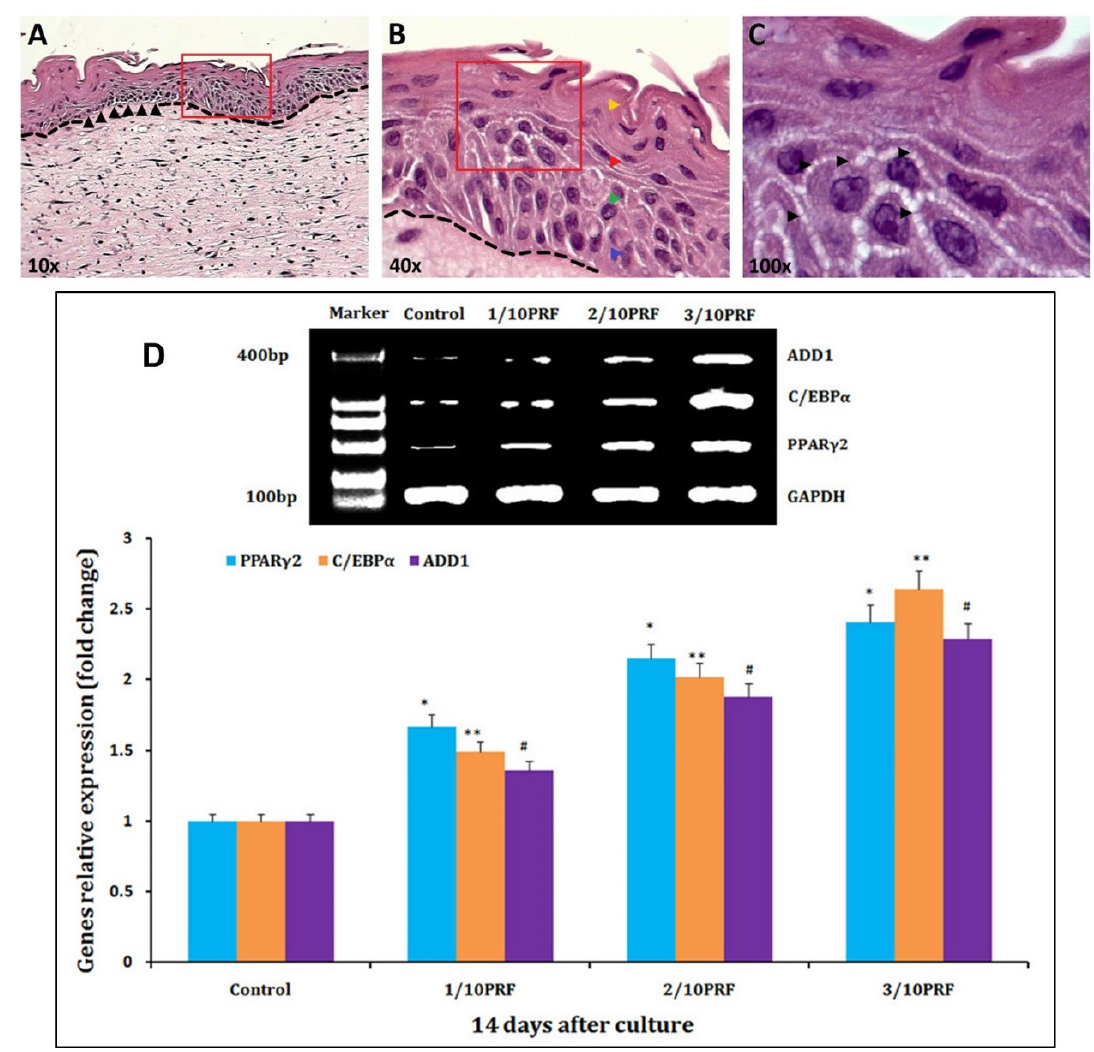
Figure 10. Histological features of skin organotypic cultures (ORGs) determined by H&E, after 21 days. ( A ) Whole structure of the ORGs (10×). A clear dermal–epidermal separation (dashed line) and a possible basal membrane (black head arrows) can be seen. ( B ) The enhanced area (40×) indicated by the red inset in ( A ). Four differentiation stages of the epidermis: the basal layer (blue head arrow), the spinous layer (green head arrow), the granular layer (red head arrow), and the horny layer (yellow head arrow), and the morphological associated changes in keratinocytes through the different layers of the epidermis. ( C ) Enhanced (100×) image indicated by the red inset in ( B ). The black arrows indicate hemidesmosome-like structures between keratinocytes. ( A – C ) Reprinted/adapted with permission from Ref. [97]. 2016, Elsevier. ( D ) mRNA levels of PPARγ2, C/EBPα, and ADD1 mRNA, which are adipogenic marker genes, are higher in the platelet-rich fibrin (PRF) groups than in the control group after 14 days of culture. * p < 0.01, ** p < 0.01, # p < 0.01. Reprinted/adapted with permission from Ref. [98]. 2017, Impact Journals, LLC.